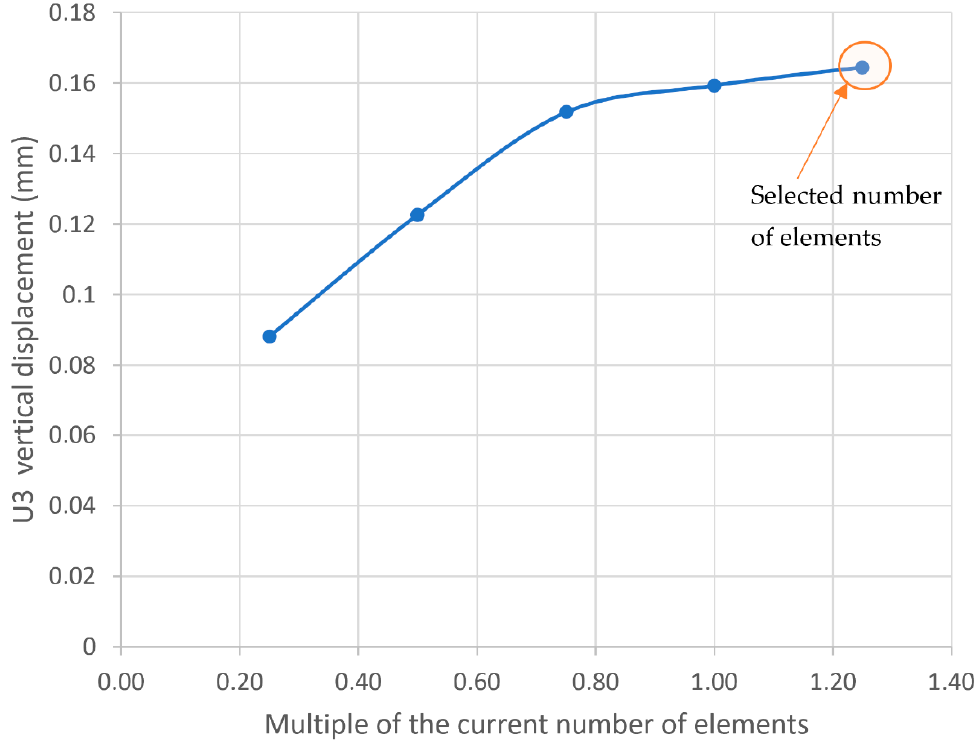
Figure 4. Convergence of the vertical displacement with the variation of the number of elements.